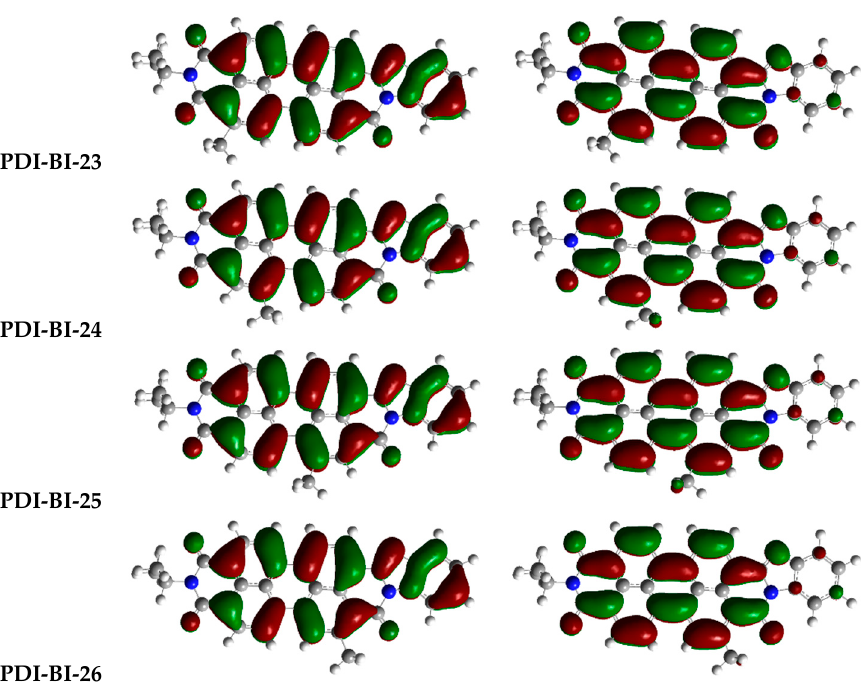
Figure 2. The distribution patterns of FMO for PDI-BI and its derivatives at the CAM-B3LYP/6-31G(d) level. Table 2. The predicted E HOMO , E LOMO , E g , λ abs-max , λ abs-min , and R values of PDI-BI and its derivatives at the TD-B3LYP/6-31+G(d,p)//CAM-B3LYP/6-31G(d)